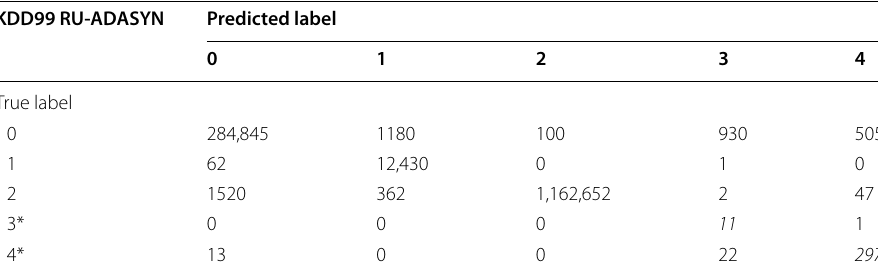
Table 18 Confusion Matrix: KDD99 RU-ADASYN KDD99